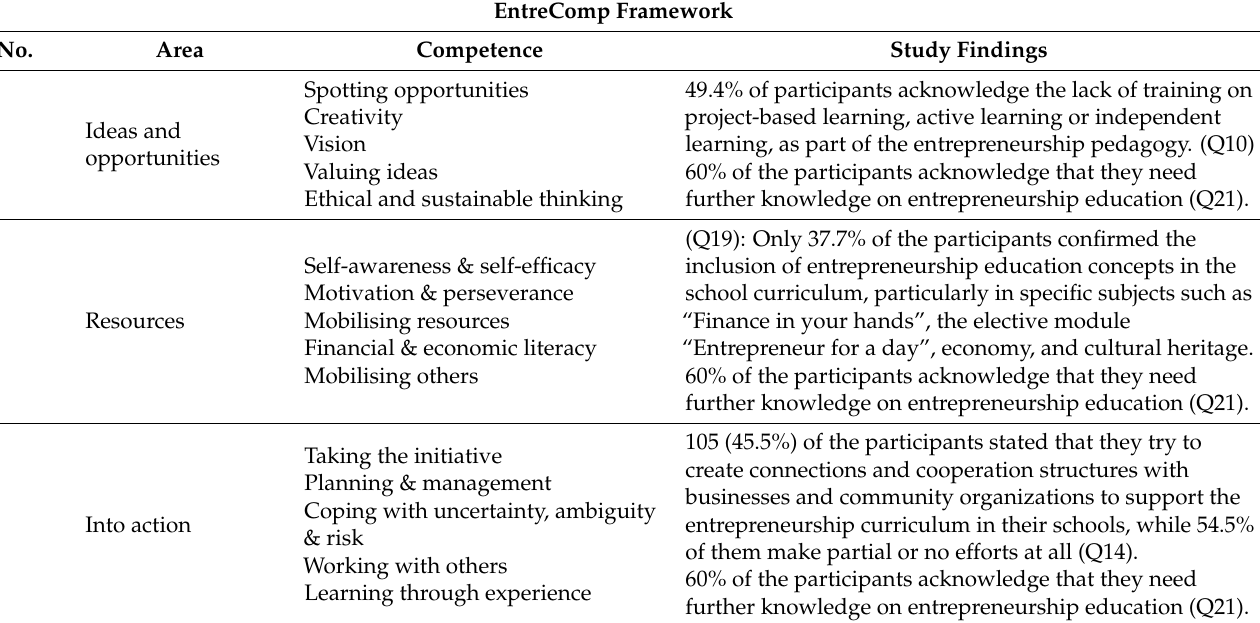
Table 8. Study Findings in the light of EntreComp